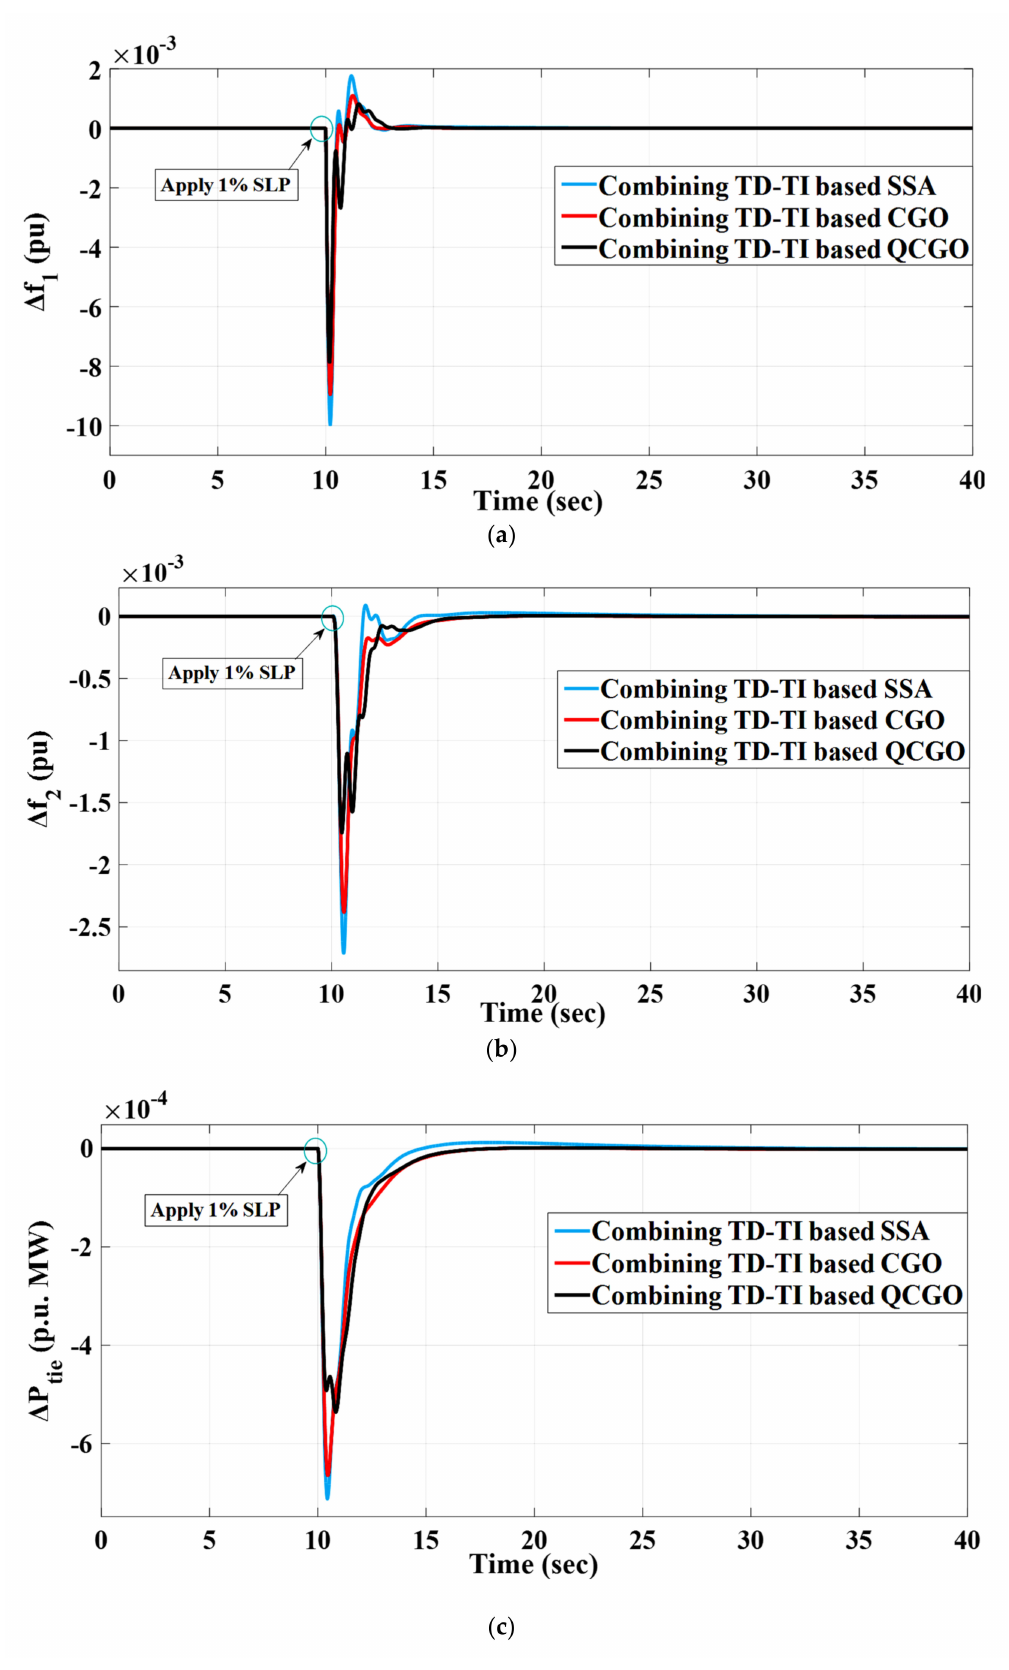
Figure 16. Dynamic power grid responses in case A.1.3: ( a ) ∆ f